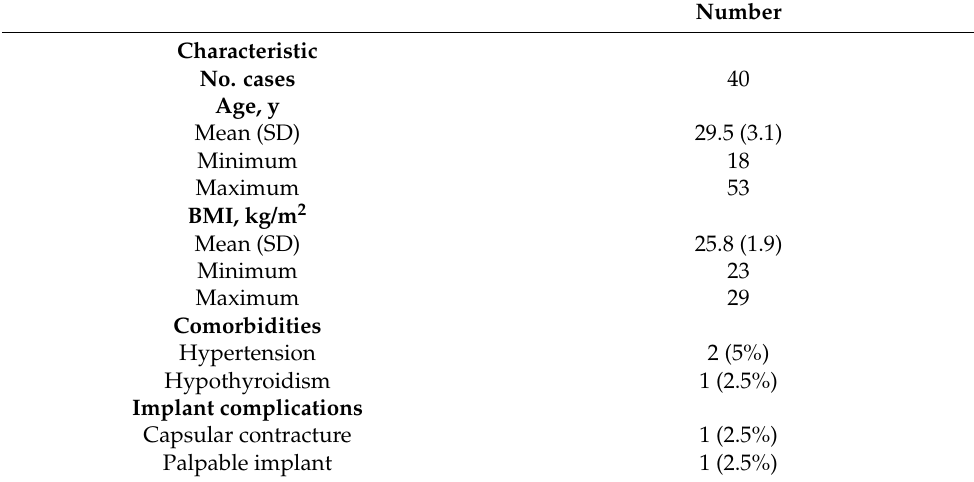
Table 2. Study data.